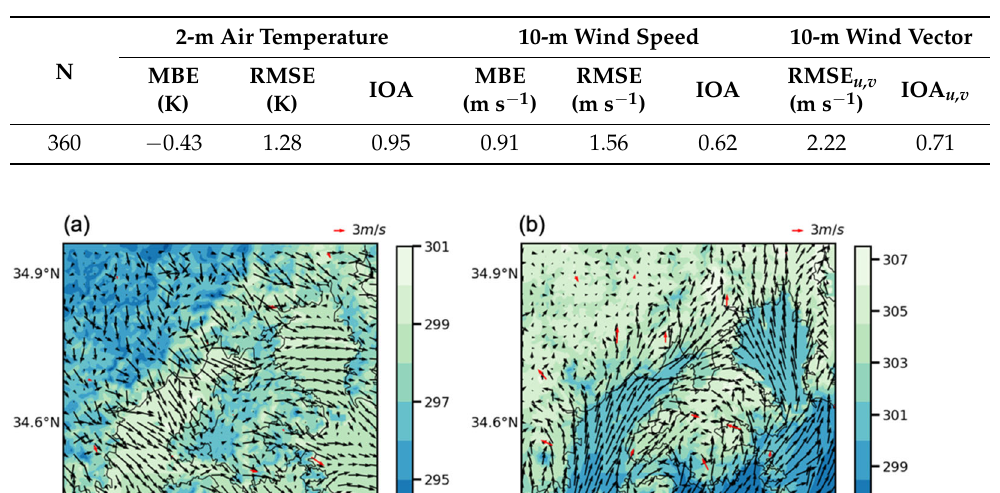
Figure 4. Horizontal distribution of simulated near-surface temperature and wind vectors (black) with observed wind vectors (red) in D04 at ( a ) 03:00 LST and ( b ) 15:00 LST on 15 July 2018. Table 3. Model evaluation statistics for near-surface variables against the observations from 15 AWS/ASOS stations in D04 on 15 July 2018. MBE, RMSE, and IOA indicate the mean bias error, root-mean-square error, and index of agreement, respectively. N represents the number of data.